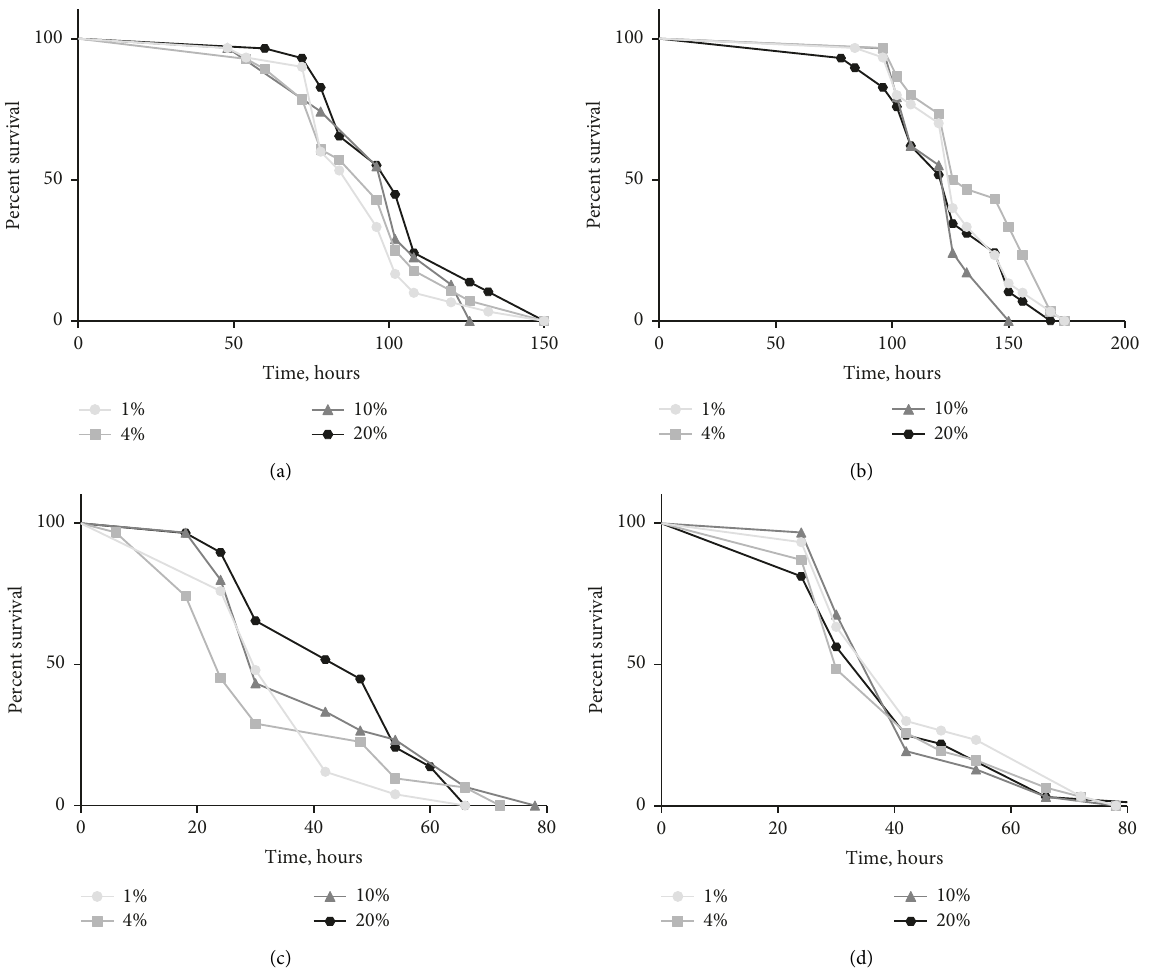
Figure 1: Resistance to starvation in males (a) and females (b), as well as oxidative stress resistance in males (c) and females (d). Each curve shows the fraction of individuals alive as a function of time with approximately 50 flies per group. The statistical analysis of differences in survival was conducted with a log-rank test. Table 1: Two-way ANOVA of the impact of dietary sucrose concentration, sex, and their interaction on the investigated parameters. Concentration, DF � 3 Sex, DF � 1 Induces studied SOD activity